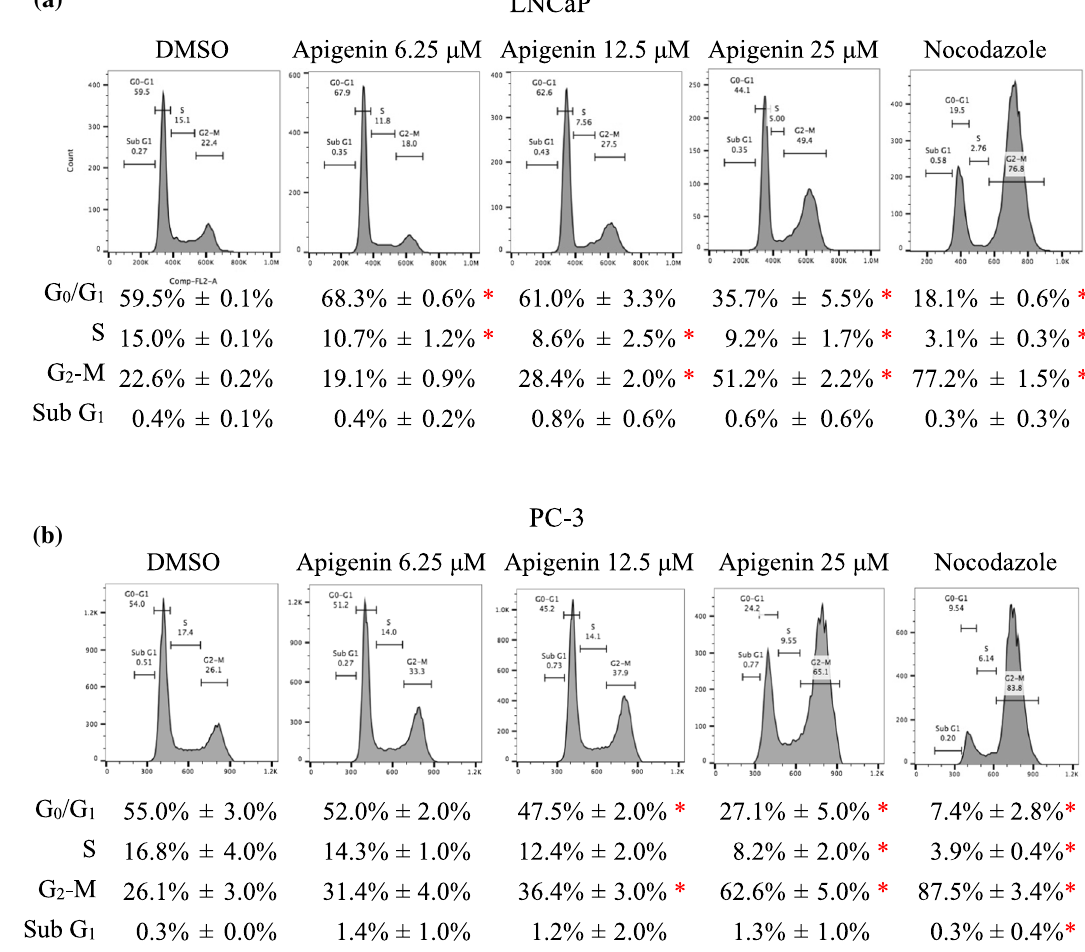
Fig. 2 Apigenin increased prostate cancer cells at G /M phase. a LNCaP and b PC-3 cells were treated with apigenin at indicated doses for 2 72 h and stained with PI for cell cycle analysis. Cells treated with nocodazole (0.8 µg/mL) for 16 h were used as a reference. Representative histograms of PI staining were presented. Cell cycle distribution in percentage was expressed as the mean ± SD from three independent experiments. *p < 0.05 compared to